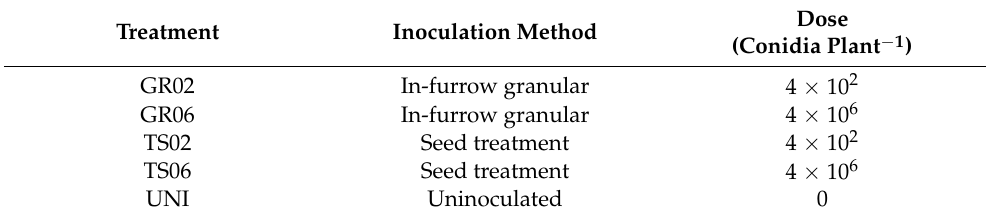
Dose (Conidia Plant − 1 )